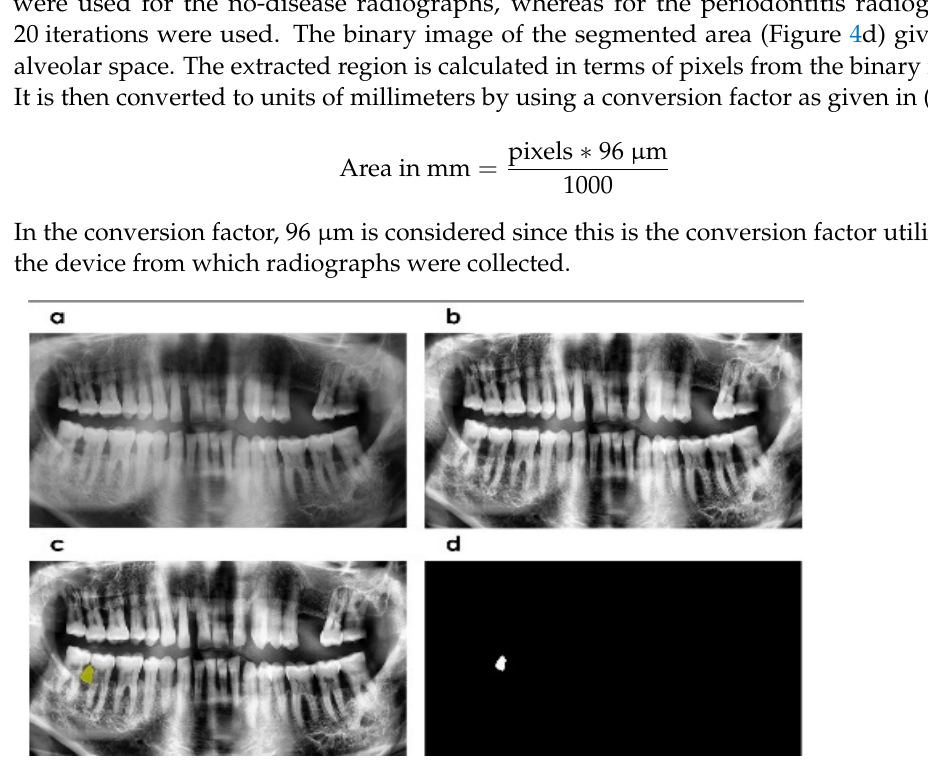
Figure 4. ( a ) Radiograph before image enhancement, ( b ) Image enhancement by CLAHE, ( c ) Image segmentation to compute the alveolar space between two intermediate teeth, and ( d ) binary image of segmented part.